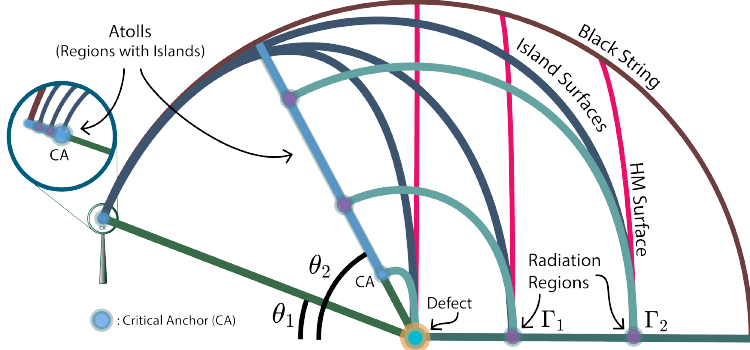
Figure 3 . This cartoon illustrates the relevant RT surfaces for different brane angles θ 1 , 2 below the critical angle. Island surfaces end on the brane at right angles, and HM surfaces cross the black-string horizon and traverse the Einstein-Rosen bridge. Islands always attach to the brane inside the atoll, which begins at a point called the critical anchor and extends to the black-hole horizon. Decreasing the brane angle reduces the size of the atoll, which shrinks to the horizon as θ → 0 . Increasing the size of R , bounded by Γ , pushes the anchors (in purple) toward the black-hole horizon; increasing the brane angle pushes the anchors toward the defect. The critical anchor, which is the point on the brane that determines the size of the largest island on the brane (which always corresponds to Γ = 0 ), coincides with the defect above the critical angle. See figure 5 for numerical